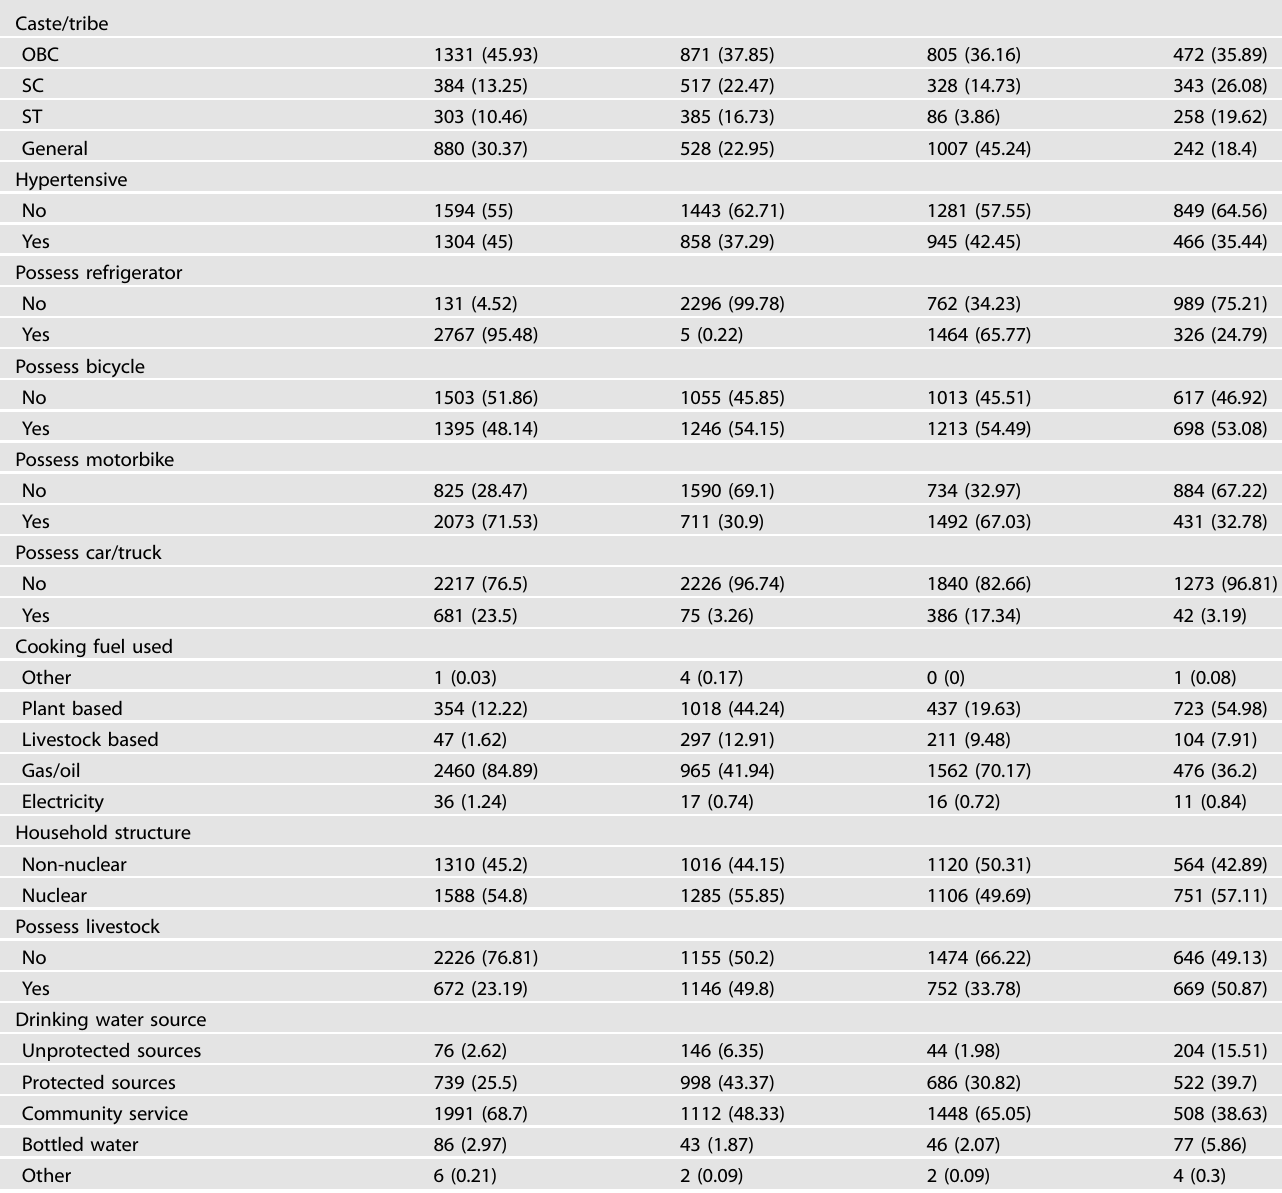
3. Only 3.26% and 3.19% of patients belonging to Cluster 2 and Cluster 4 respectively possess a car/truck compared to 23.5% and 17.34% of patients belonging to Cluster 1 and Cluster 3, respectively. 4. 44.24% and 54.98% of patients belonging to Cluster 2 and Cluster 4 respectively, use plant-based cooking fuel, which is relatively cheap, compared to 12.22% and 19.63% of patients belonging to Cluster 1 and Cluster 3 respectively. Moreover, only 41.94% and 36.2% of patients belonging to Cluster 2 and Cluster 4, respectively use gas/oil-based cooking fuel, which is relatively expensive, compared to 84.89 and 70.17% of patients belonging to Cluster 1 and Cluster 3, respectively. 5. 6.35% and 15.51% of patients belonging to Cluster 2 and Cluster 4 respectively, drink water from unprotected sources, compared to 2.62% and 1.98% of patients belonging to Cluster 1 and Cluster 3,